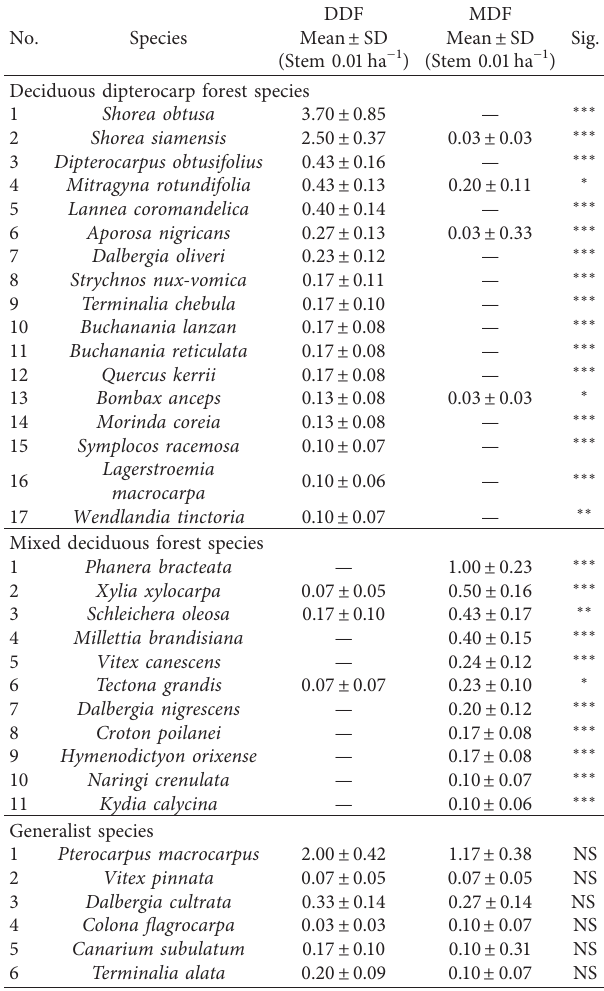
Table 2: Density (mean ± standard deviation) of mature trees (DBH ≥ 4.5cm) of each species in the deciduous dipterocarp forest (DDF) and mixed deciduous forest